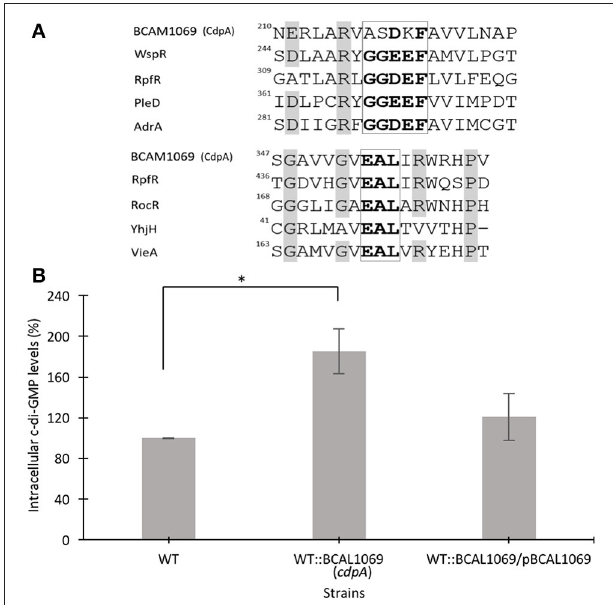
FIGURE 4 | Multiple sequence alignment of residues of signature motifs of BCAL1069 (CdpA) and determination of intracellular levels of c-di-GMP in the BCAL1069 mutant. (A) Partial alignment of BCAL1069 amino acid sequence with GGDEF and EAL domain-containing proteins, retrieved from the UniProt database. The amino acids in the GGDEF and EAL motifs are highlighted in bold. Other conserved amino acids are shaded in gray. The numbers show the position of the amino acid in the protein. BCAL1069, UniProt Id B4ED05; WspR, UniProt Id Q9HXT9; RpfR, UniProt Id B4EKM4; PleD, UniProt Id Q9A515; AdrA, UniProt Id Q9L401; RocR, UniProt Id Q9HX69; YhjH, UniProt Id P37646; VieA, UniProt Id O68318. (B) Relative intracellular c-di-GMP levels in the WT:BCAL1069 mutant. Percentage represents area under the c-di-GMP curve of the strain relative to the WT strain. Three independent experiments were performed. *Denotes significant p -values ( p <